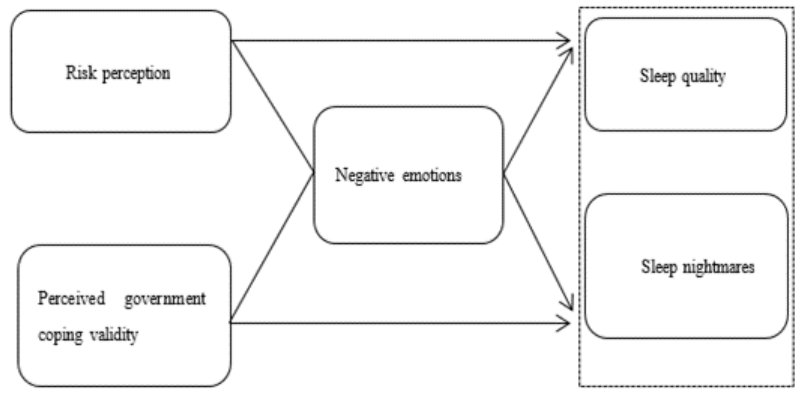
Figure 1. A conceptualized analytical framework.